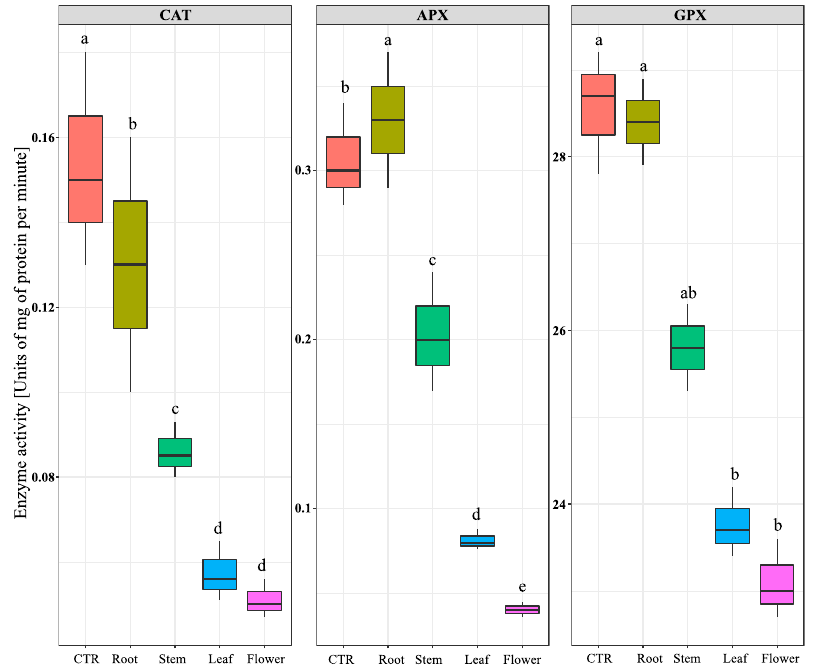
Figure 6. Effect of N. meyeri extracts on antioxidant enzymes in C. campestris (Dodder) plants. Dodder plants were treated either by distilled water (CTR) or extracts from different parts of N. meyeri. Different letters indicate statistically significant differences calculated by Duncan multiple mean comparison method (n = 3, p ‐ value < 0.05). Table 3. Effect of N. meyeri extracts from different organs of on C. campestris and alfalfa vegetative traits and parasitation rate after attachment. Numbers represent means and ± standard deviations calculated for each phenotype, respectively. ANOVA analyses (n = 3, p ‐ value < 0.05) were performed for each trait. Different letters indicate statistically significant differences. ns: not significant; Fw: fresh weight; Dw: dry weight.